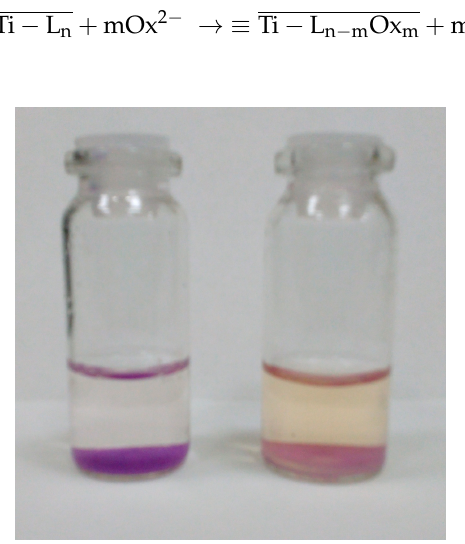
Figure 5. The color of Si-Ti/ECR before (left) and after (right) interaction with 200 mg/L oxalate solution (pH 3.0 m/V = 0.10 g/ 5.0 mL, time of contact is 15 min).